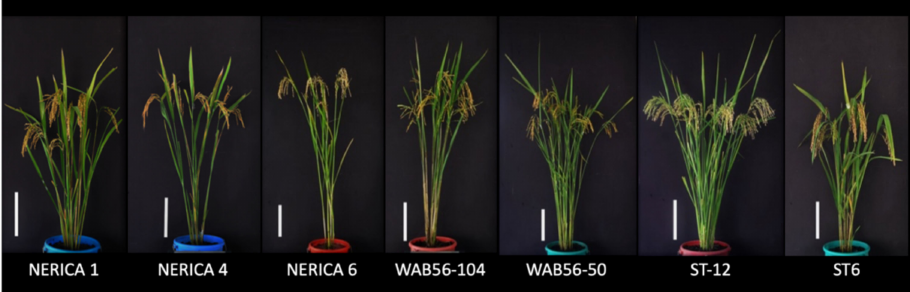
Figure 9. Gross morphology of NERICA and WAB rice cultivars, and the Gn1a and WFP rice line donors ST12 and ST6. Scale bar = 20